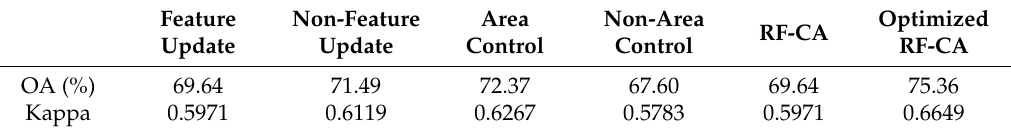
Table 8. The accuracy of the corrections with or without a feature update and area